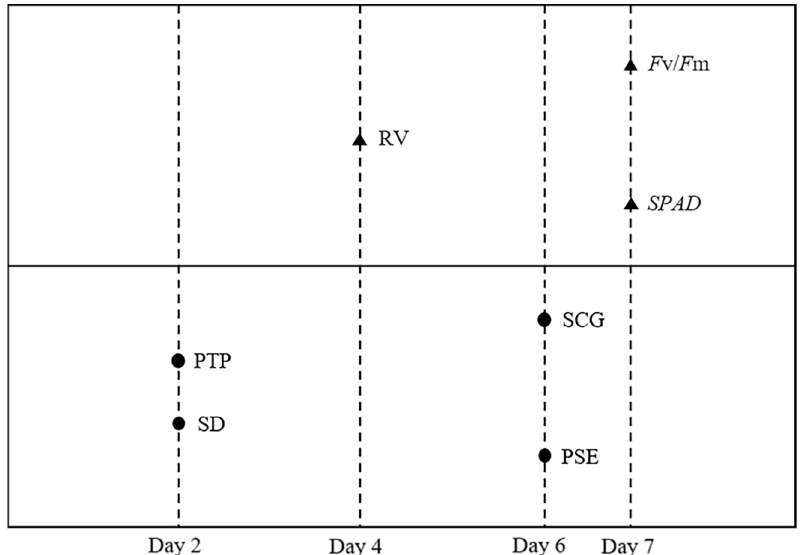
Figure 8. A schematic comparison of electrical signals and physiological parameters that showed significant differences between drought and control treatments (Day 1–Day 8), with triangles indicating physiological parameters and dots indicating electrical parameters. PTP was peak-to-peak value, mean was mean value, SD was standard deviation, SCG was the Spectral of Central Gravity, and PSE was power spectrum entropy. RV was Root Vitality, SPAD was the Relative Amount of Chlorophyll, and Fv/Fm was Maximal Photochemical Efficiency.